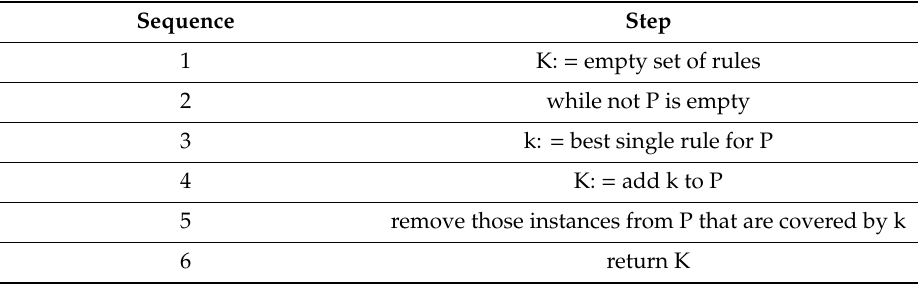
Table 2. Pruning algorithm